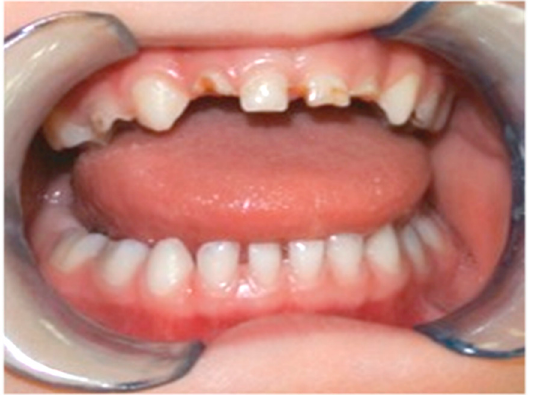
Figure 1. Early childhood caries affecting the primary maxillary anterior teeth of a small child.